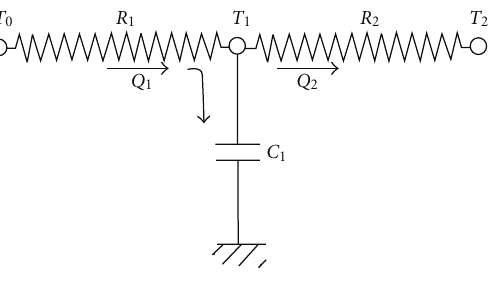
Figure 8: Heat flow at tee